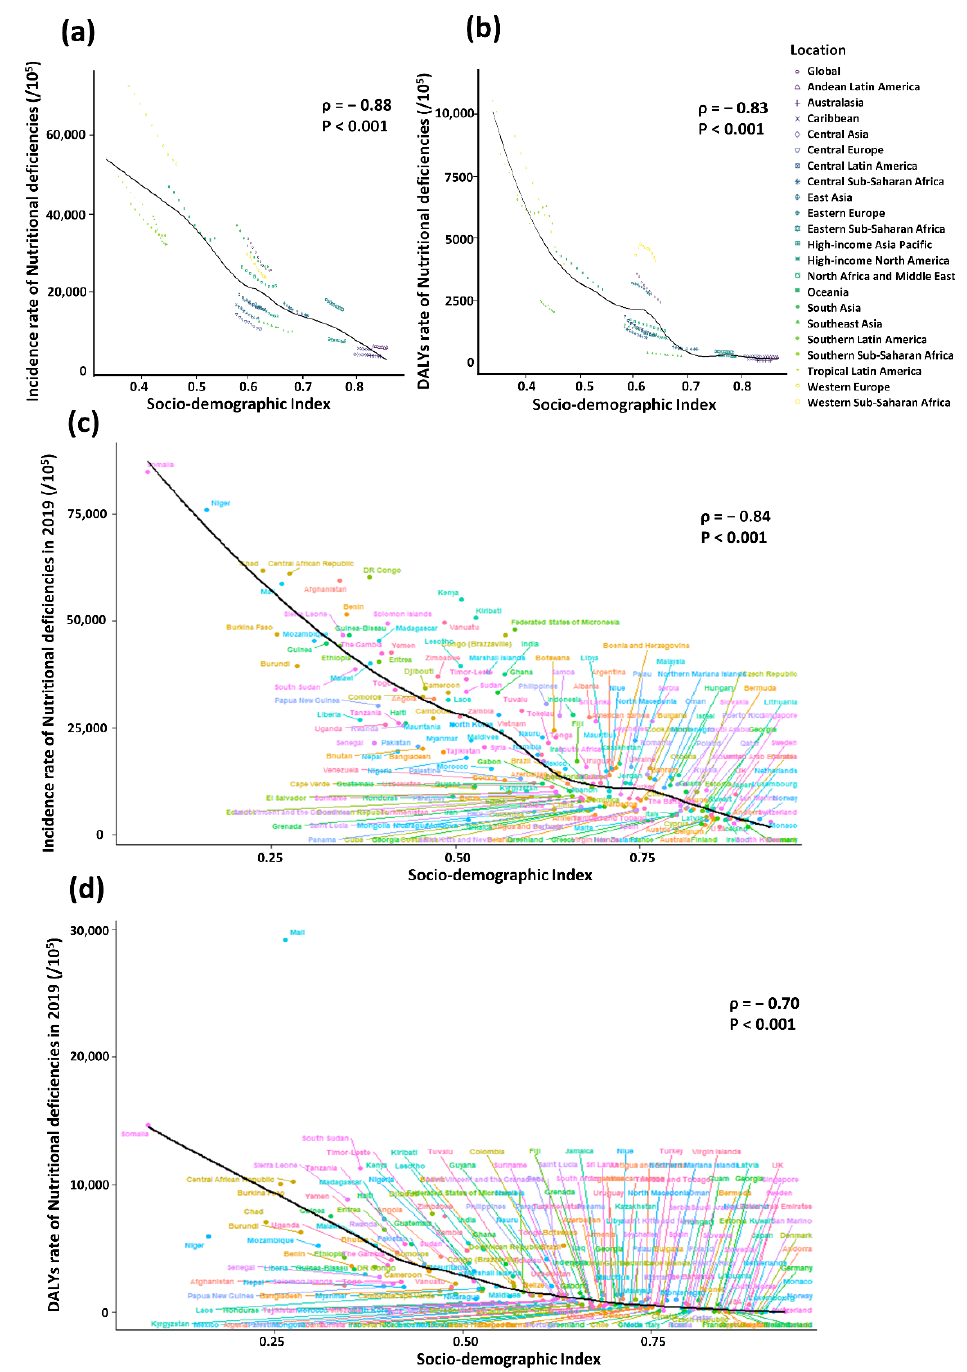
Figure 4. The correlation between socio-demographic index and incidence or DALY rate of nutritional deficiencies, 2010–2019. The correlation between socio-demographic index and incidence ( a ) or DALY rate ( b ) of nutritional deficiencies among 21 GBD regions and five SDI regions. The correlation between socio-demographic index and incidence ( c ) or DALY rate and ( d ) of nutritional deficiencies among 204 countries and